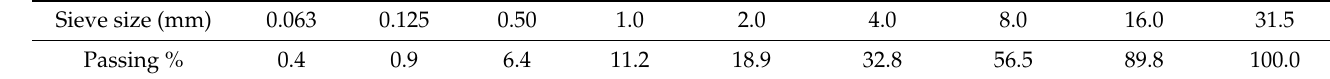
Table 2. Analysis of the gradation of reclaimed asphalt